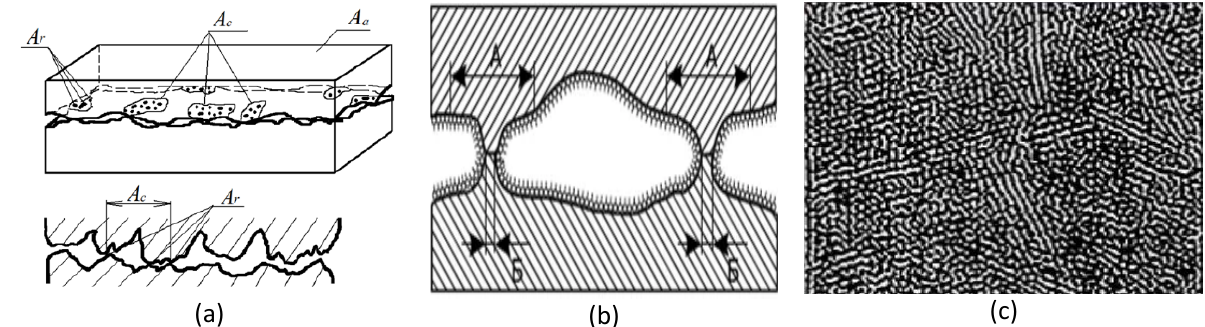
Fig. 2. Classical schemes of the adhesion-deformation model of friction of surfaces based on the concept of discreteness of actually contacting protrusions of real rough surfaces: 3D-scheme and 2D-scheme (I.V. Kragelsky, A.M. Demkin) [1,2] - (a); a schematic representation of the appearance of mutually elastically deformed sections A and the formation of adhesion sites of setting B after the destruction of the boundary monomolecular lubricant layer on the protrusions of rough surfaces (Bowden) [3] - (b); cellular structure of nanorough surfaces when the vertices merge into closed cells like honeycombs along the contour (dark areas) with multimolecular lubricant layers inside the contours (light areas) [48] -